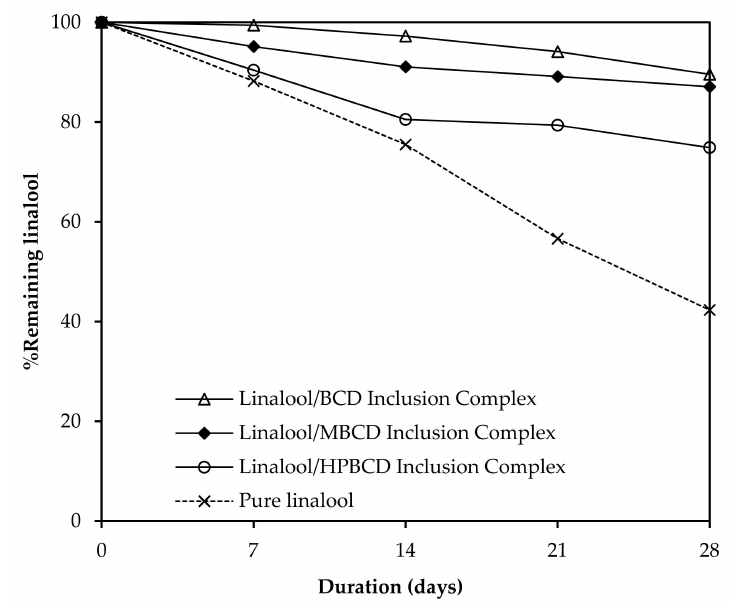
Figure 17. Stability curves of linalool/CD inclusion complexes and pure linalool.